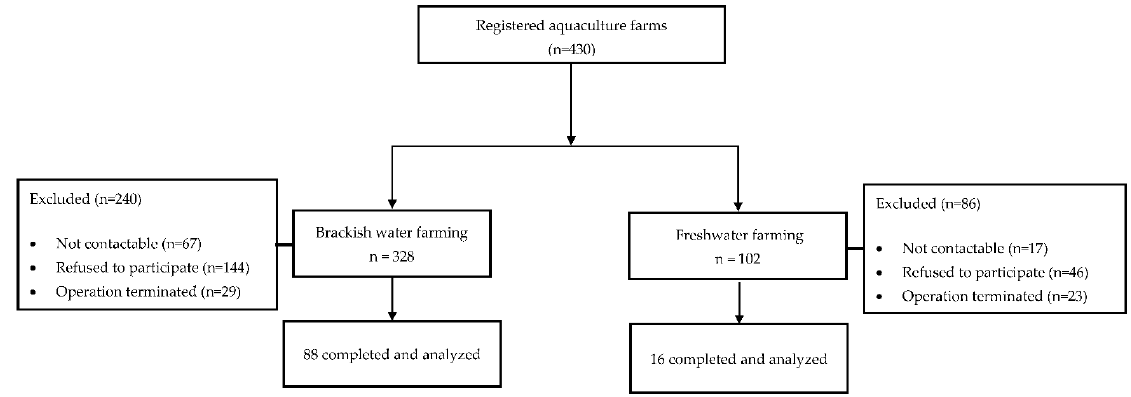
Figure 1. Subject recruitment.